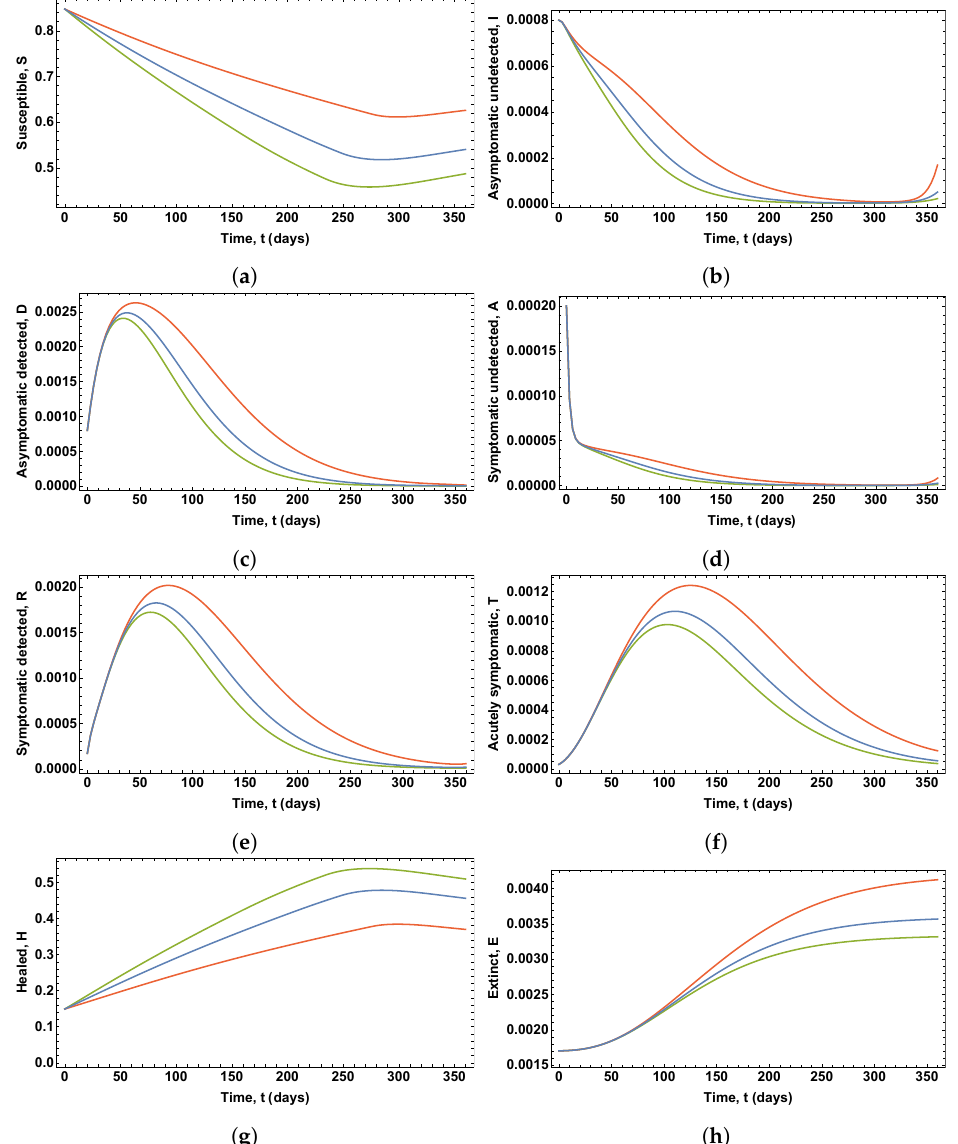
Figure 7. Proportions of people in each compartment obtained assuming vaccine efficacy levels φ = 0.50 (red), φ = 0.75 (blue), and φ = 0.95 (green), with C 1 = 1, C 2 = 0.1, and C 3 = 0.0001: ( a ) Susceptible people. ( b ) Asymptomatic undetected people. ( c ) Asymptomatic detected people. ( d ) Symptomatic undetected people. ( e ) Symptomatic detected people. ( f ) Acutely symptomatic people. ( g ) Healed people. ( h ) Extinct